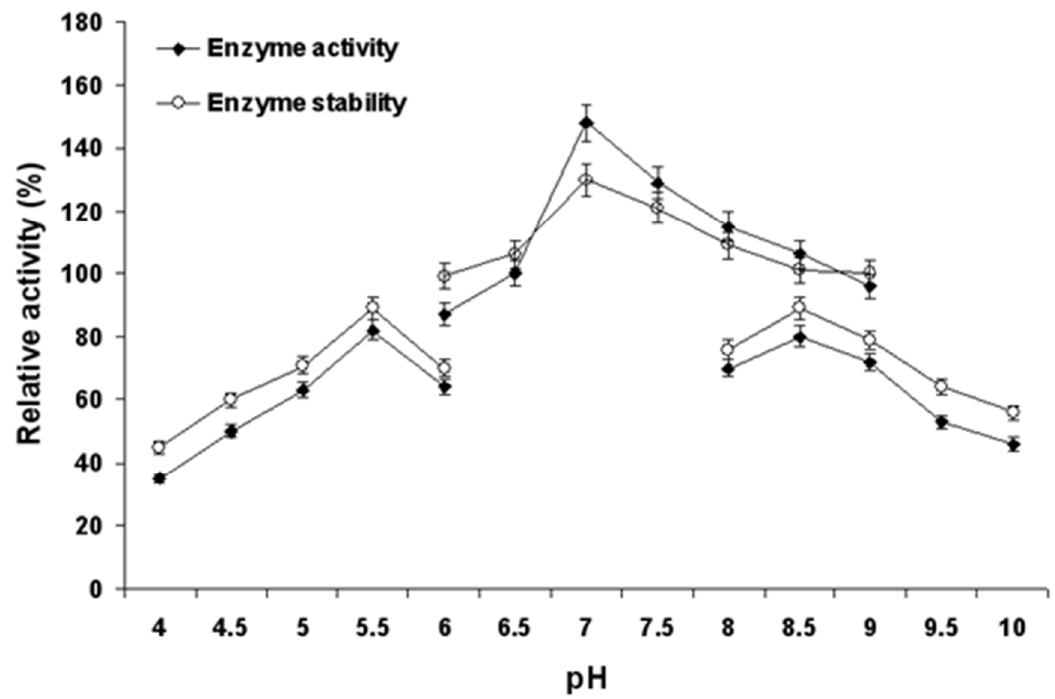
Figure 4. The impact of pH on enzyme activity and stability. For enzyme activity, the reaction was measured at the appropriate pH, and for stability, the enzyme was pre-incubated for 1 h at 55 °C with buffers (100 mM, in a 1:1 ratio) of various pH (sodium acetate (pH 4.0–6.0), sodium phosphate (pH 6.0–8.0), and Tris-HCl (pH 8.0–10.0) and then measured using a standard assay method. The enzyme assay performed at pH 7.0 (sodium phosphate buffer) and 55 °C was served as control (100%). For enzyme stability, the residual activities were compared with enzyme activity measured at pH 7 (sodium phosphate buffer) and 55 °C (100%).